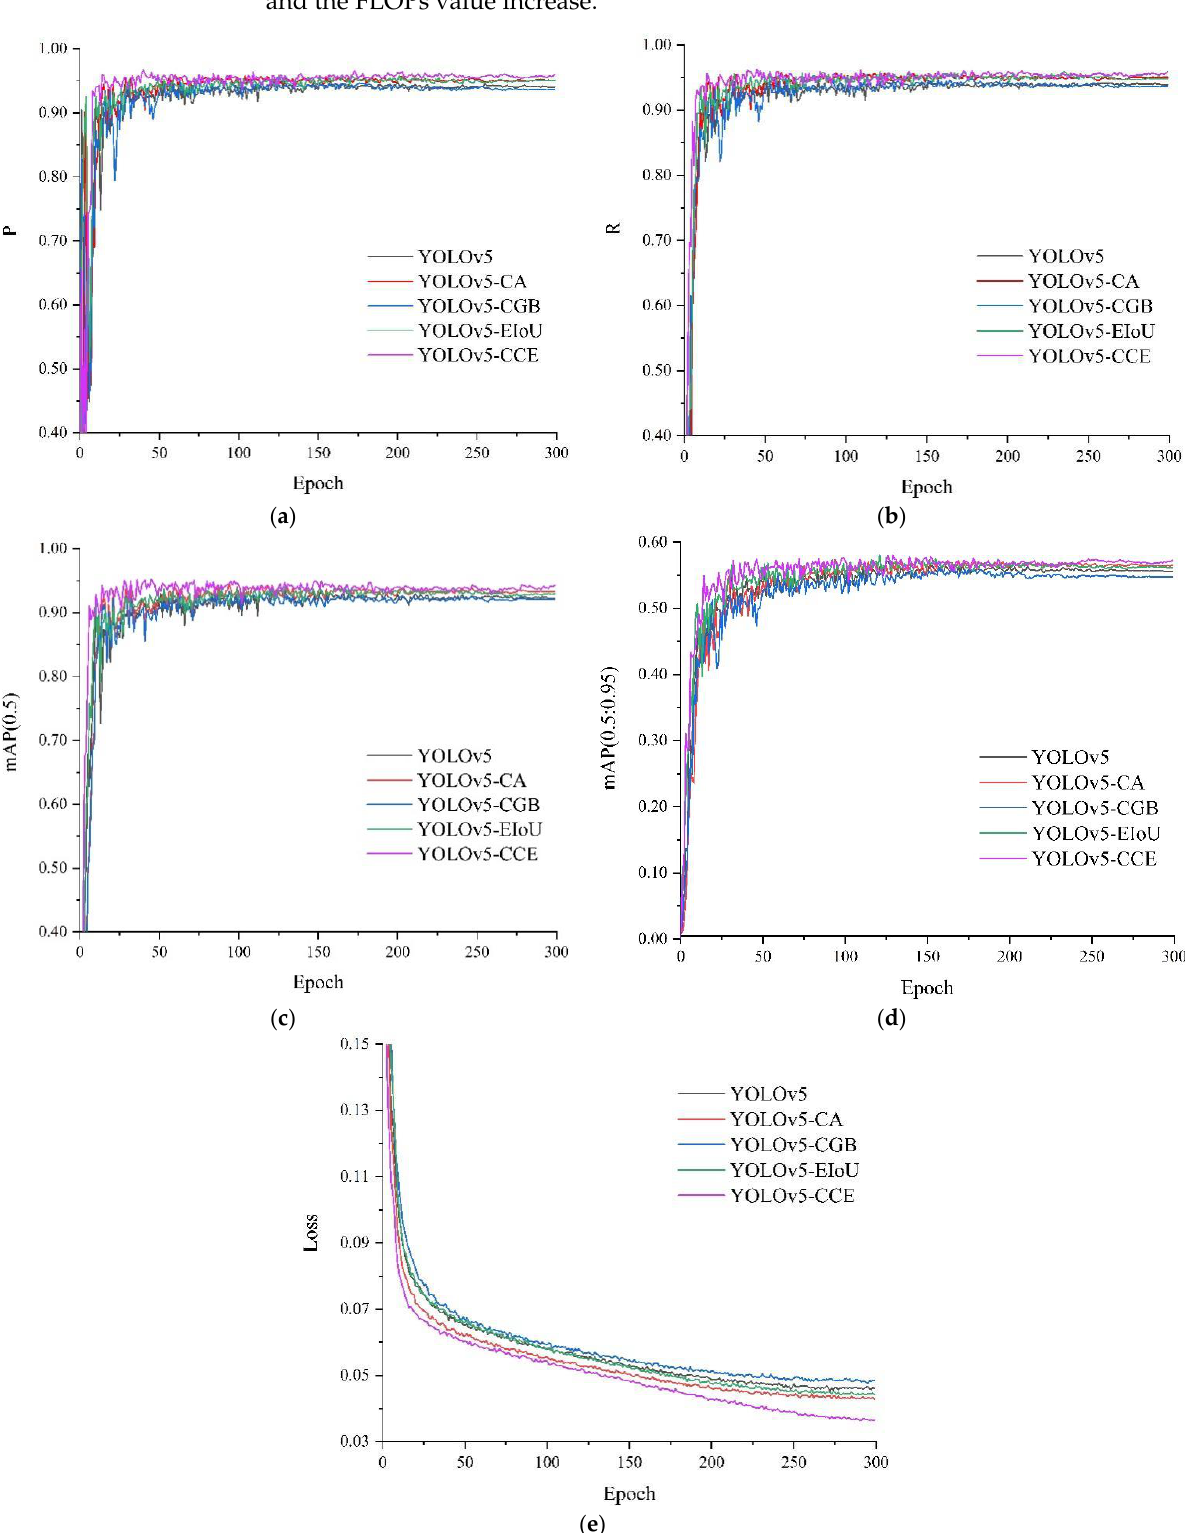
Figure 7. Results of each experiment. ( a ) The change curve of precision, ( b ) The change curve of recall, ( c ) The change curve of mAP (0.5), ( d ) The change curve of mAP (0.5:0.95), ( e ) The change curve of loss.